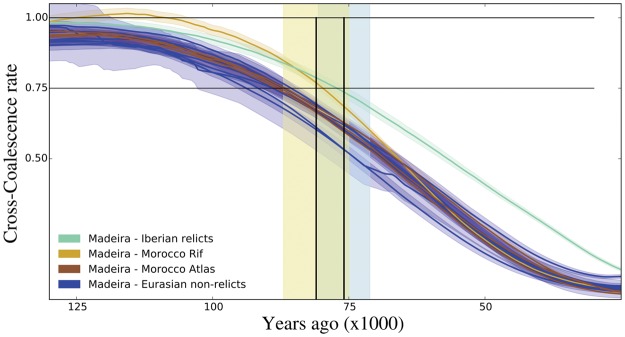
Split time between Madeira and Iberian relicts. For comparison are shown also split times between Madeira and all other mainland groups. CCR changes across time are shown smoothed with a cubic spline across median CCR for each time segment used in MSMC. Shaded areas represent confidence intervals (± 1.96 · SE). CCR decay is expected to cross the real split time between 0.70 <CCR <0.85 (see Materials and Methods). The vertical line at 75.9 ka, and the area in light blue represent the expectation and range of split times between Madeira and Iberian relicts, based on CCR. The vertical line at 81.0 ka, and the area in khaki represent the expectation and range of the same split time, based on δaδi.